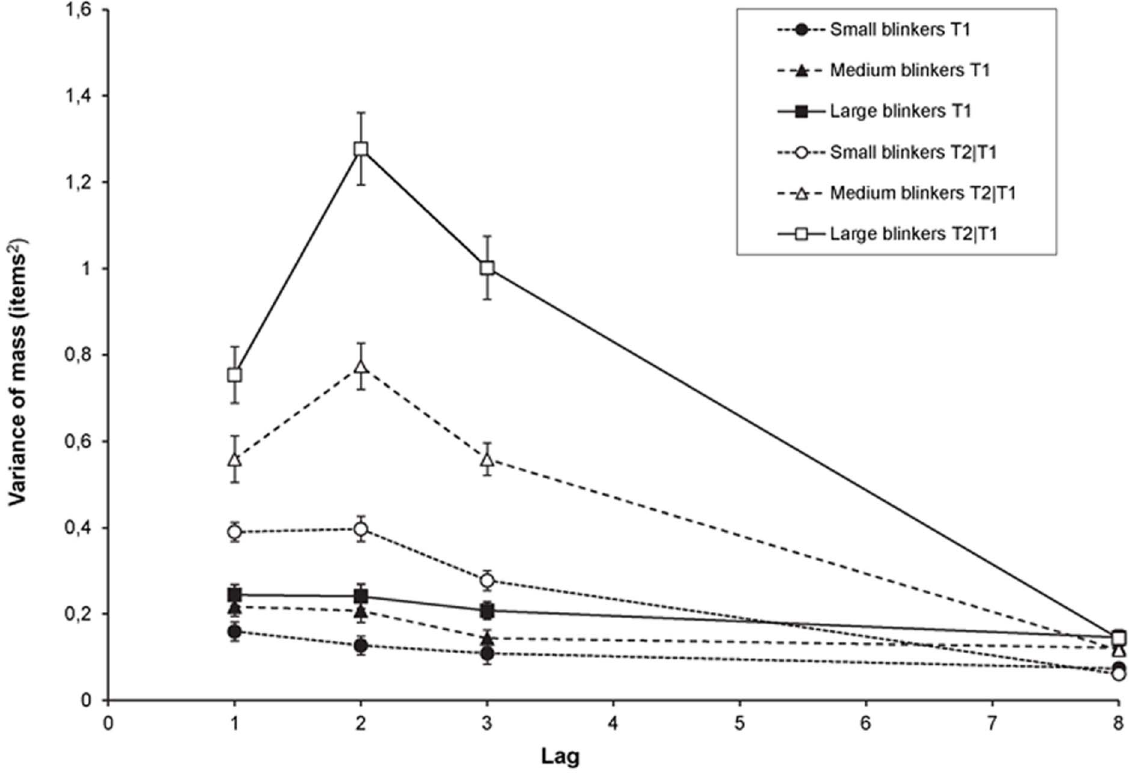
Figure 12. Diffusion in Experiment 2. Diffusion of the temporal selection process expressed as the variance of the centre of mass in the selection window around T1 or T2 as a function of lag, for small, medium, and large blinkers. doi:10.1371/journal.pone.0066185.g012 PLOS ONE |